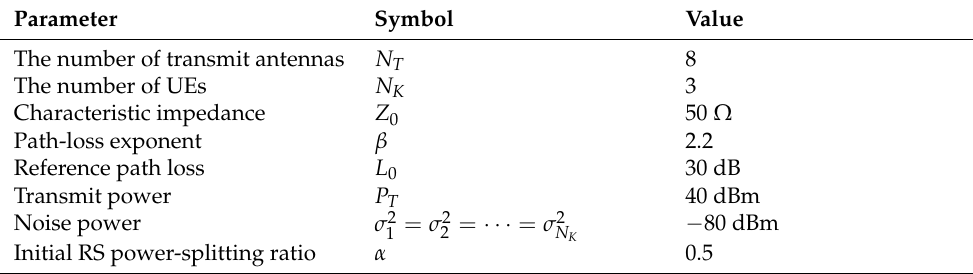
Table 1. Simulation parameters.